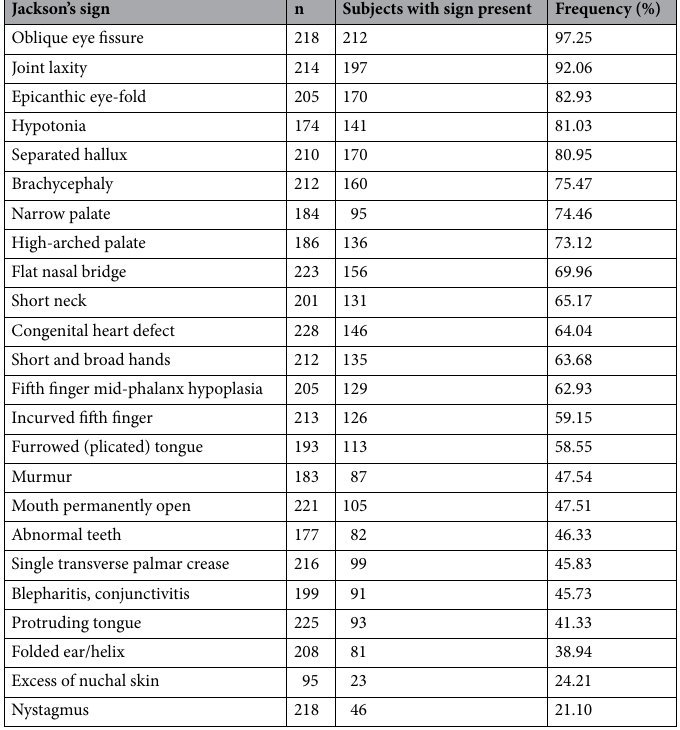
Table 1. Frequency of Jackson’s signs. Brushfield spots feature was excluded. Signs are sorted by frequency expressed as percentage. n number of subjects with available information, SD standard deviation.